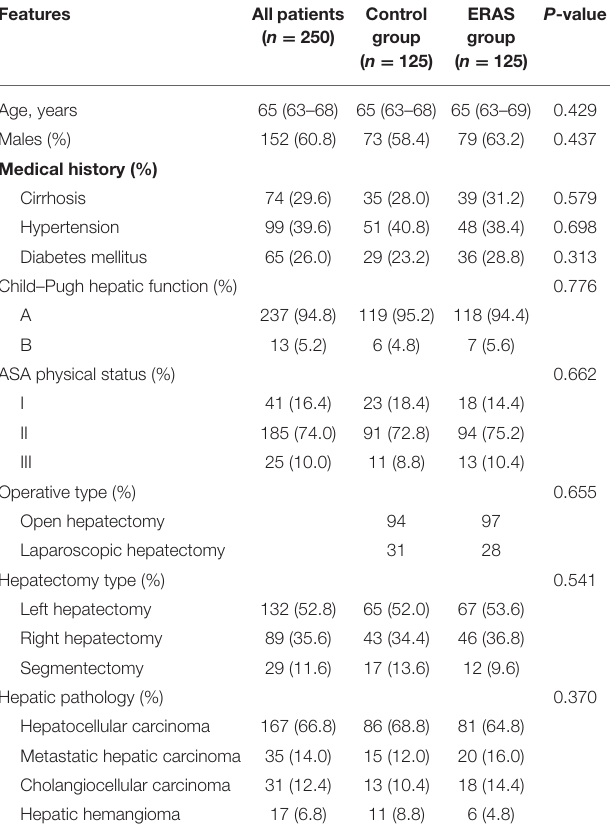
TABLE 2 | Baseline features of all patients divided into ERAS and control groups. Features